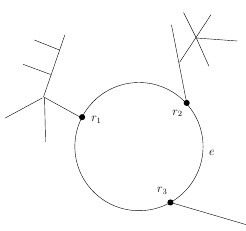
Fig. 4. g.(cid:30).c 1 // D 1